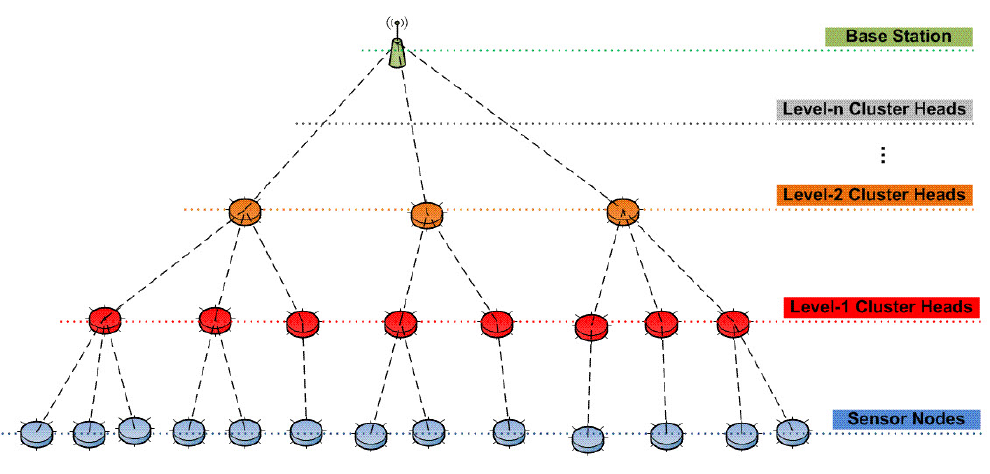
Figure 2. Multi-level clustering for our proposed IDS